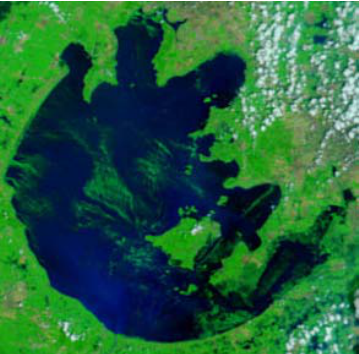
Figure 1 Location, morphology and division of Taihu